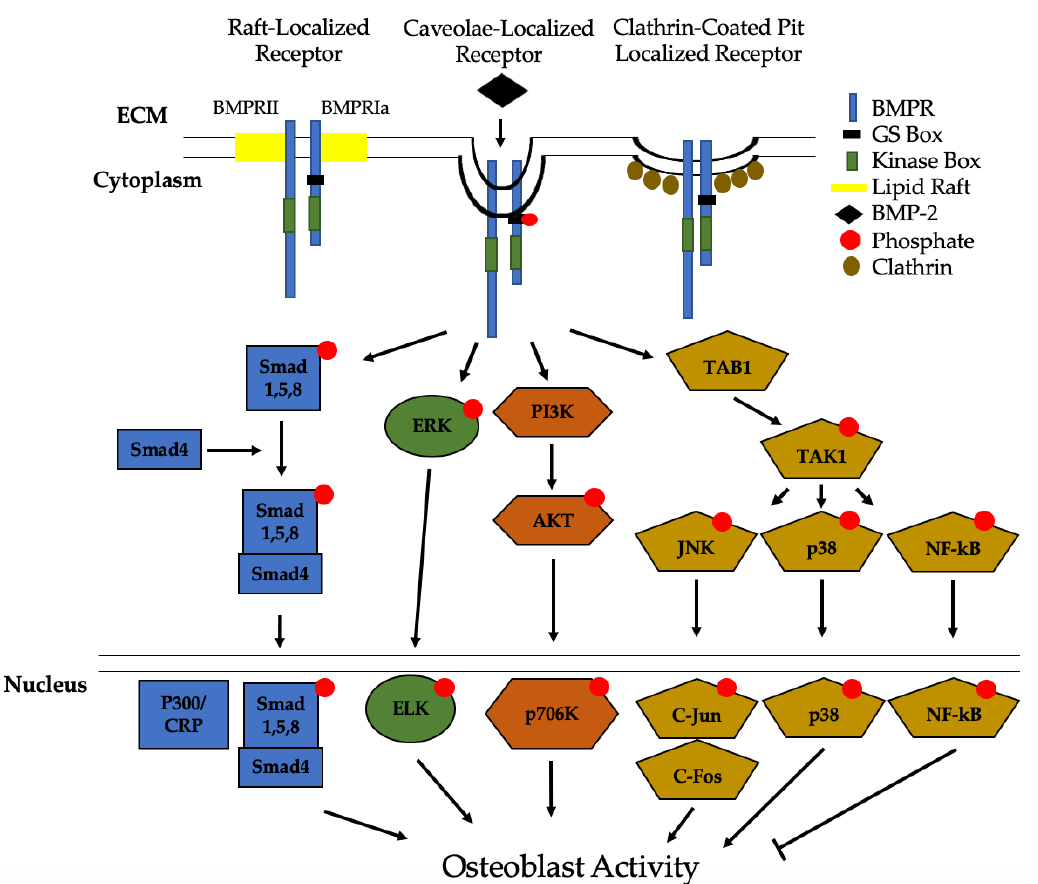
Figure 3. Bone Morphogenic Protein 2 (BMP-2) activation of signaling pathways. Once BMP-2 binds to the BMPRs located in lipid rafts, caveolae, and clathrin coated pits (CCPs), constitutively active BMPRII phosphorylates BMPRIa. This leads to downstream activation of the Smad pathway or the non-Smad pathways. In non-Smad signaling, the extracellular signal-related kinase (ERK), phosphatidylinositol 3-kinase (PI3K), and the transforming growth factor- β -activated kinase 1/binding protein 1 (TAB1/TAK1) pathways are activated. All of these pathways, except for NF-kB, lead to an increased differentiation of MSCs and osteoprogenitors into osteoblasts.